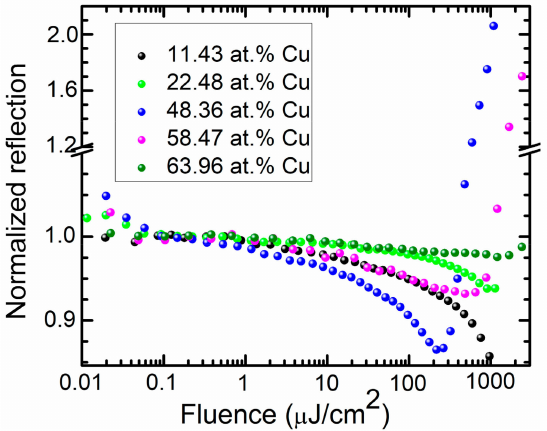
Figure 9. The normalized reflectance vs laser fluence for the selected hydrogen-free DLC:Cu films.